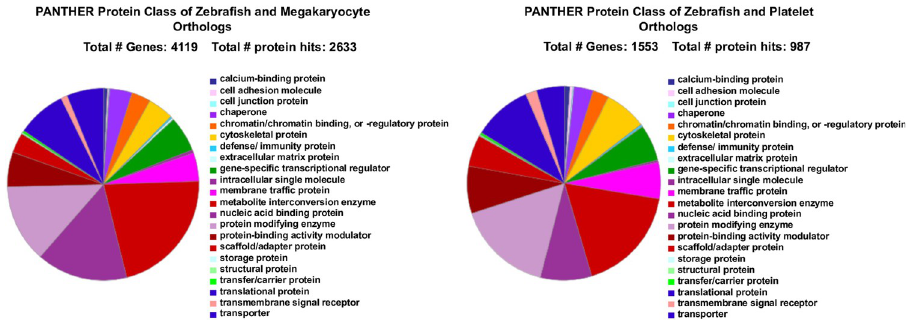
Fig 8. PANTHER analysis and classification of human orthologs of total thrombocyte gene transcripts found in human megakaryocytes and platelets. A. The 9143 total thrombocyte gene transcripts and 7708 human megakaryocyte gene transcripts were combined in a spreadsheet and color-coded. Then duplicate genes were selected first and the duplicates were eliminated to give a list of 4224 human orthologs which were uploaded into the PANTHER program, and Danio rerio species was selected. The program detected 4119 genes and yielded a total number of 2633 protein hits for these genes. B. The 9143 total thrombocyte gene transcripts and 2819 human platelet gene transcripts were combined in a spreadsheet and color-coded. Then duplicate gene transcripts were selected first, and the duplicates were eliminated to give a list of 1603 gene transcripts for human orthologs, which were uploaded into the PANTHER program, and Danio rerio species was selected. The program detected 1553 genes and yielded a total number of 987 protein hits for these genes. In both A and B, the percentage of each of the protein classes for RFP + and GFP+ gene lists are shown by different colors in the pie chart, and their classification is provided by its side with similarly coded